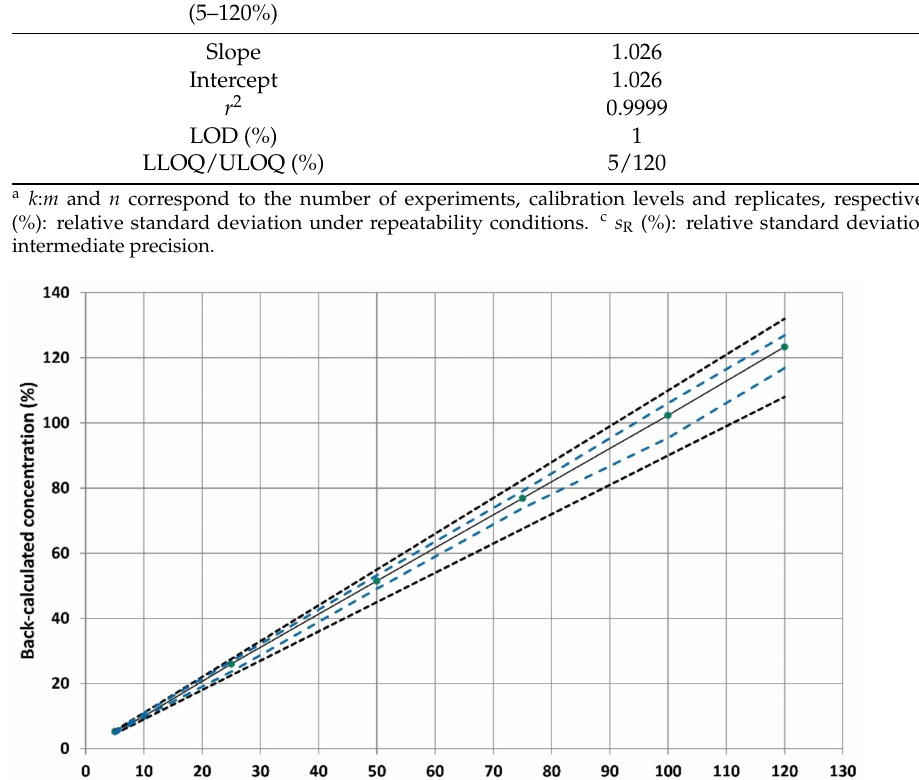
Figure 3. Linearity profile for CAP determination. The plain blank line corresponds to the identity line (Y = X), the blue dashed line represents the accuracy profile ( β -ETI) and the dotted curves illustrate the acceptance limits λ ± 10% expressed in the %